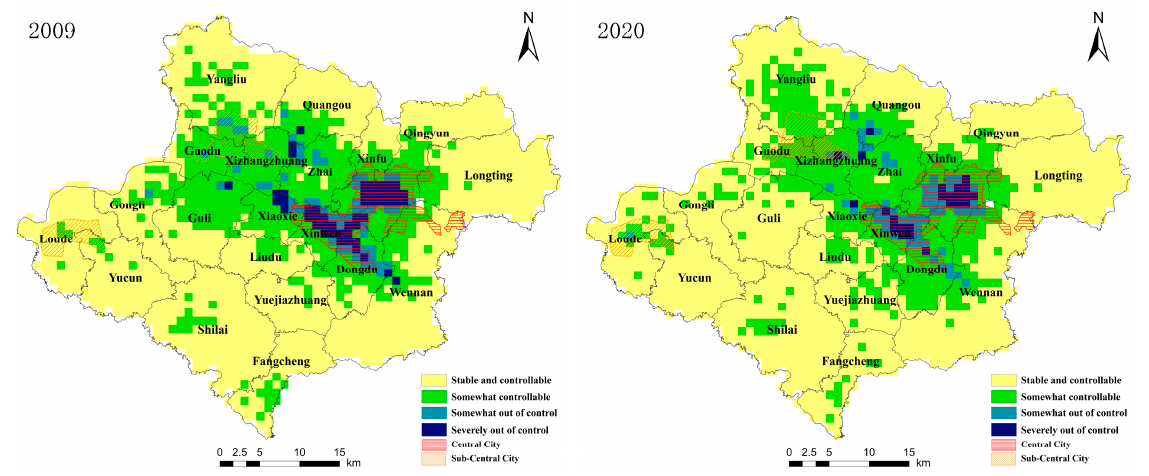
Figure 4. Spatial conflict patterns of Xintai,